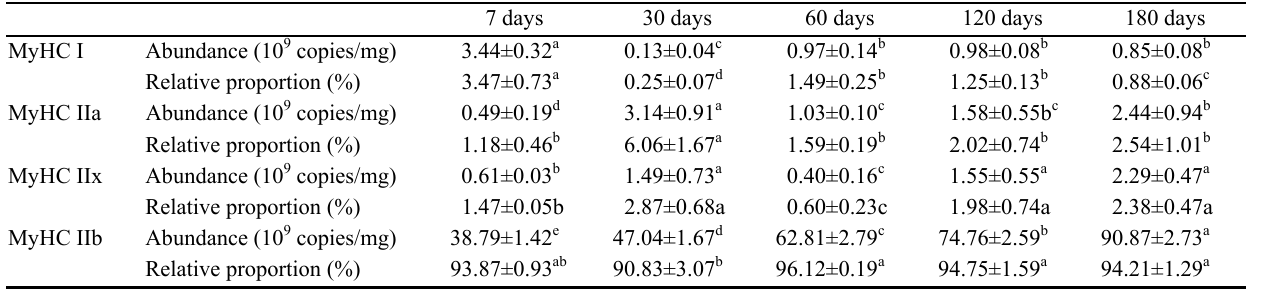
Table 2. Comparison of MyHC mRNA transcription in LM of pigs with different postnatal ages